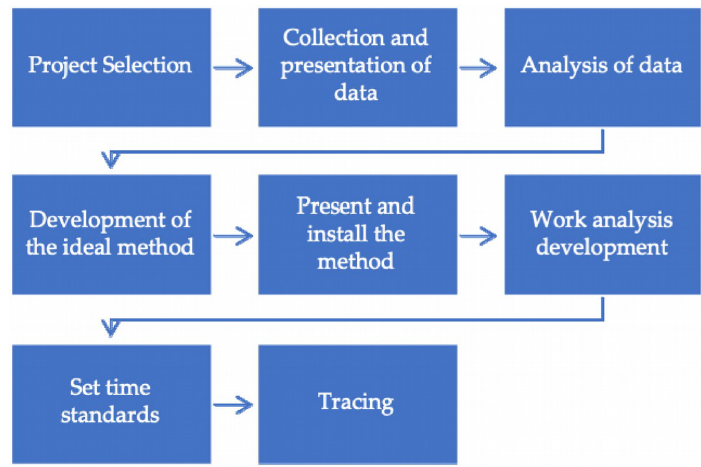
Figure 2. Program of Method Engineering (Niebel & Freivalds,